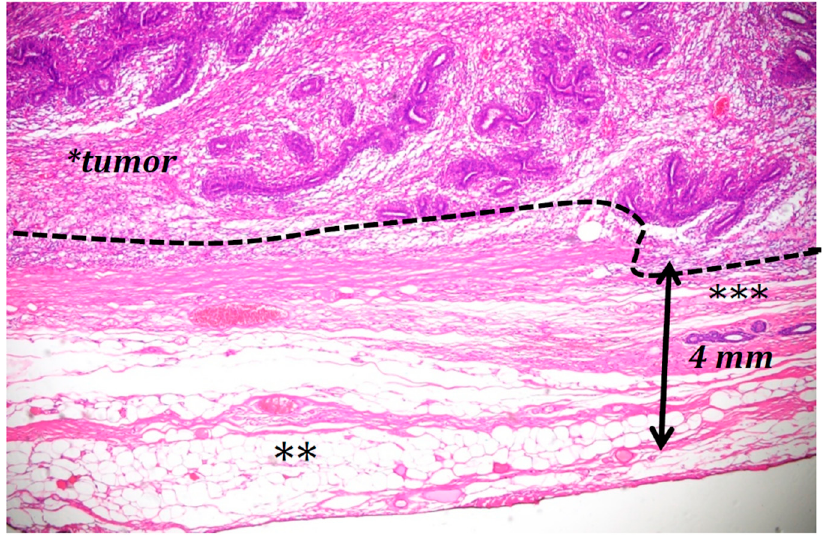
Figure 5. Borderline phyllodes tumor (*) with a negative surgical margin; the distance between the ink on the resection margin (black arrow) and tumor borders (dotted line) varying from 4 to 6 mm; the adipose tissue ** and a few normal ducts *** are present at the edge of the histological section (H&E staining).